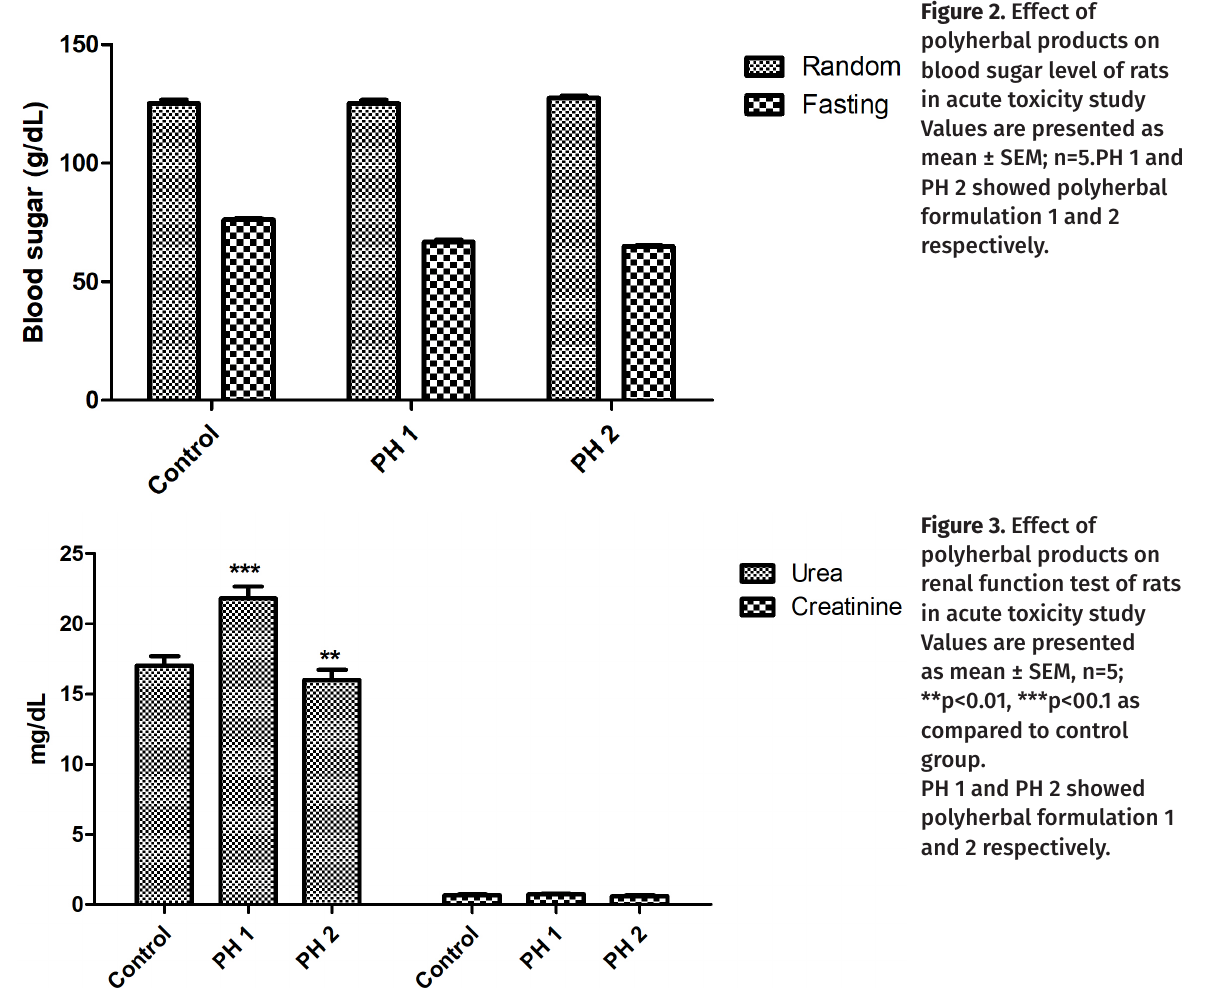
Figure 2. Effect of polyherbal products on blood sugar level of rats in acute toxicity study Values are presented as mean ± SEM; n=5.PH 1 and PH 2 showed polyherbal formulation 1 and 2 respectively.